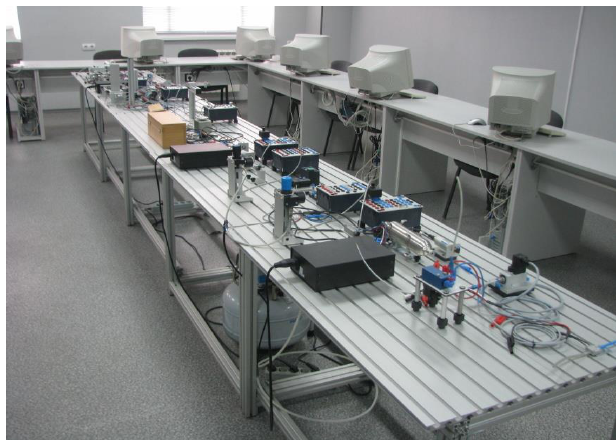
Figure 9. Laboratory of sensorics of automated